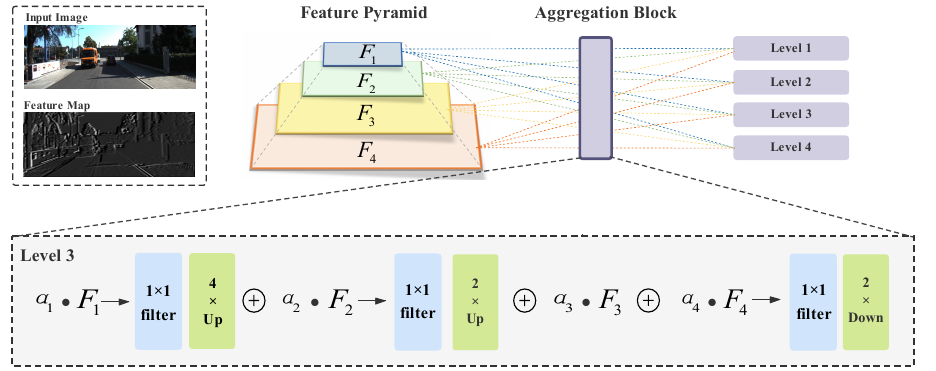
Figure 4. Visualization of a feature fusion sample result and a brief illustration of feature aggregation. For each level, each layer of the original feature pyramid is resized to specific size and the number of channels and fused with specific